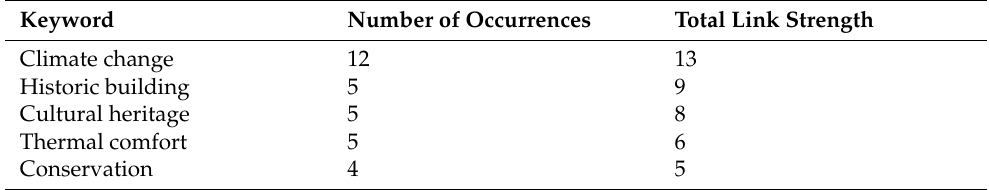
Table 3 synthetizes the author keywords with the highest number of occurrences. Table 3. Top-five authors’ keywords with the highest number of occurrences (and link